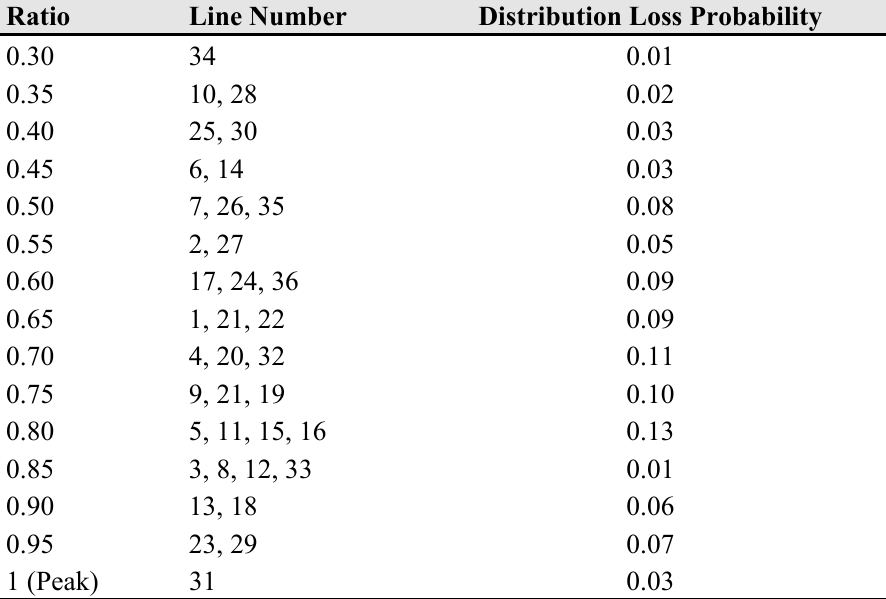
Table 7. The power rate of